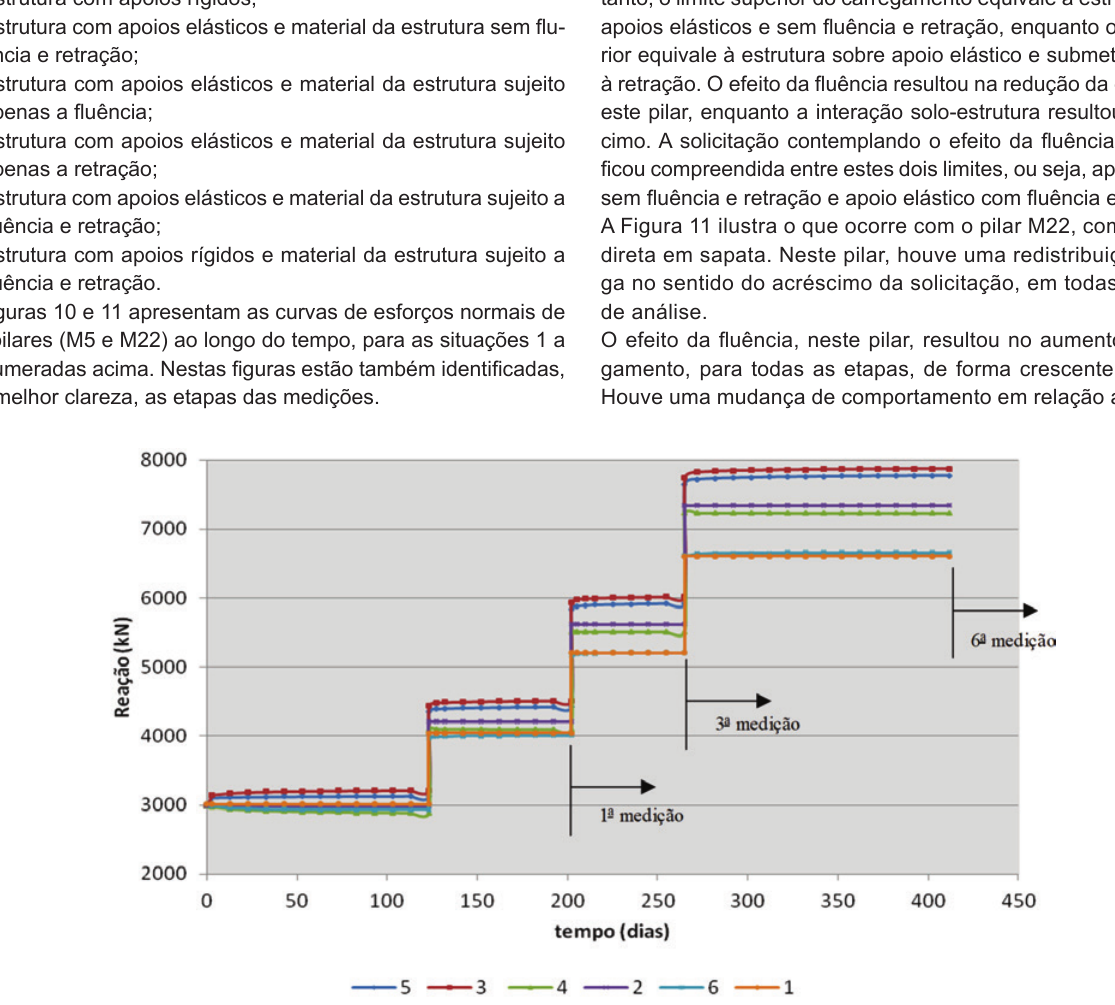
Figura 11 Esforço normal ao longo do tempo para o pilar M22, considerando as seis situações